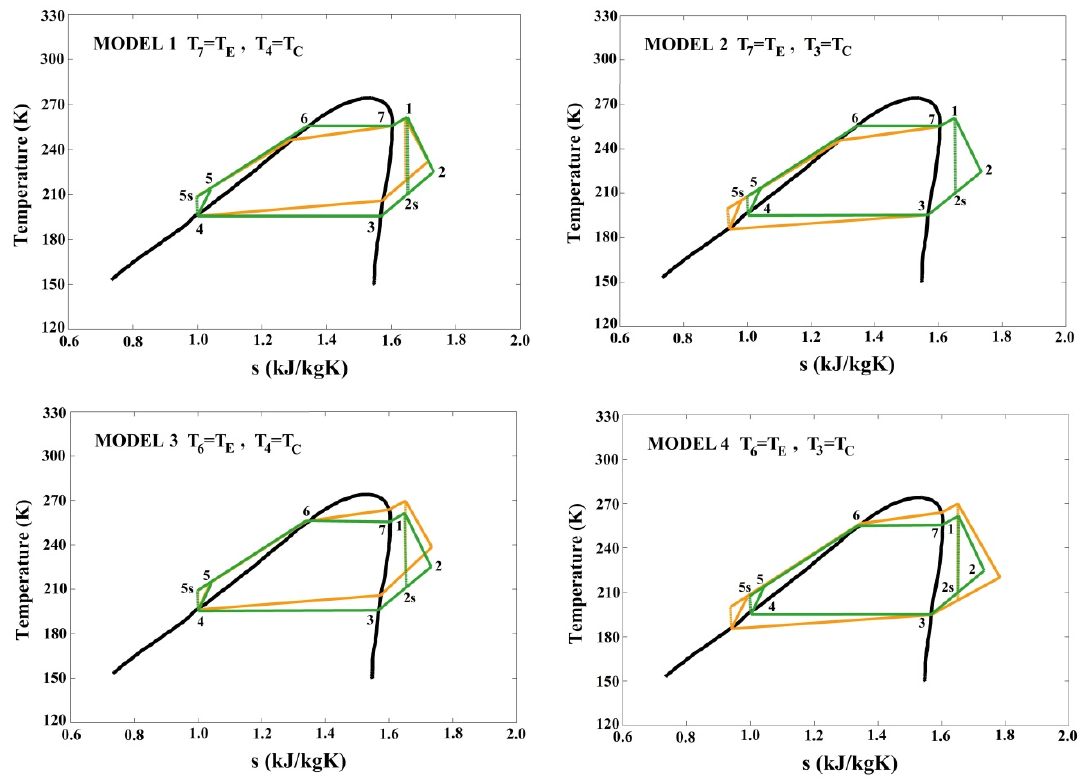
Figure 1. The temperature-entropy diagram of the four considered models. The green diagrams represent the pure fluid cycle, while the orange diagrams represent the mixture working fluid [17].